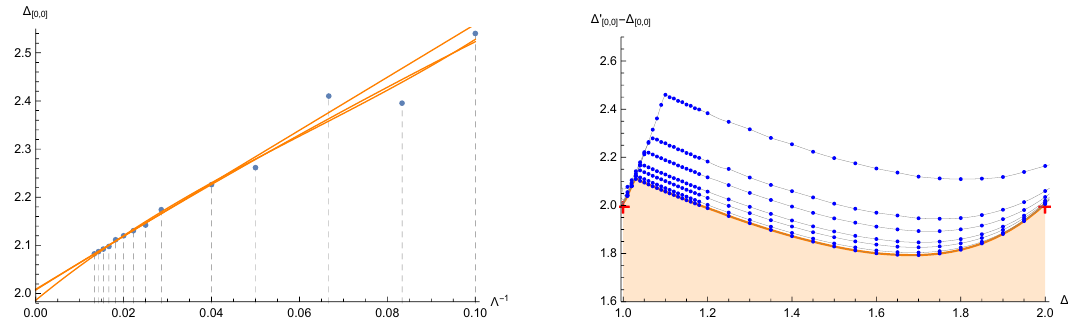
Figure 3 . Left: upper bounds on (cid:1) as a function of (cid:3) (cid:0) 1 . Several (cid:12)ts (linear while ignoring [0 ; 0] the (cid:12)rst 4 points, quadratic and cubic) were done are plotted in orange. Extrapolated to (cid:3) ! 1 , they lead to (cid:1) (cid:20) 2 : 009 ; 2 : 007 ; 1 : 986 respectively. Right: bounds on the di(cid:11)erence (cid:1) 0 [0 ; 0] between the conformal dimensions of the (cid:12)rst two longs for a given (cid:12)rst long with dimension (cid:1) The plot was done for (cid:3) = 20 ; 30 ; : : : ; 80 and only the allowed region for (cid:3) = 80 was shaded. The left red dot denotes the analytic solution (C.1) for (cid:24) = (cid:0) 1, while the right one corresponds to (cid:24) =